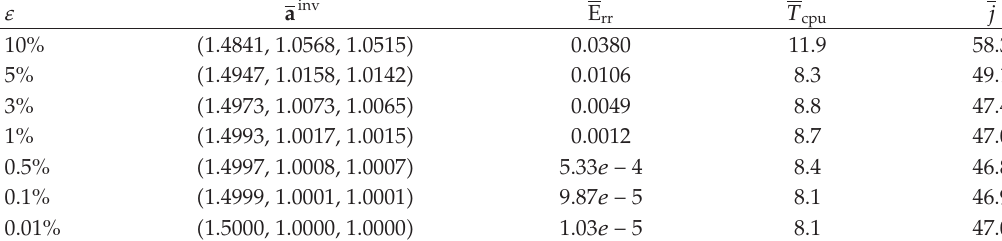
Table 9: Inversion results with random noises using μ (cid:8) 0 .